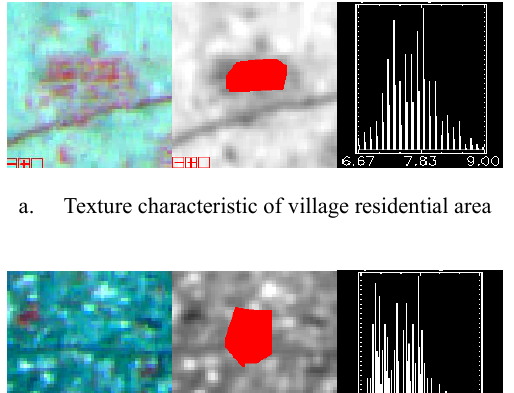
Fig.6 Corp land and man-made area in blue band 4.2.4